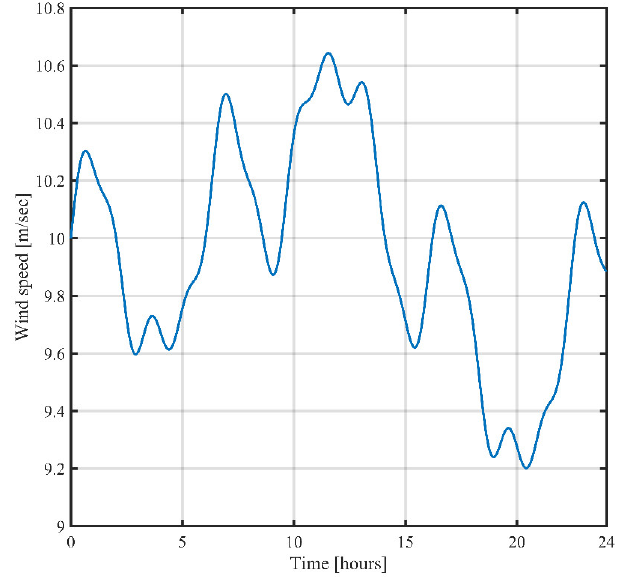
Figure 20. Wind speed profile.